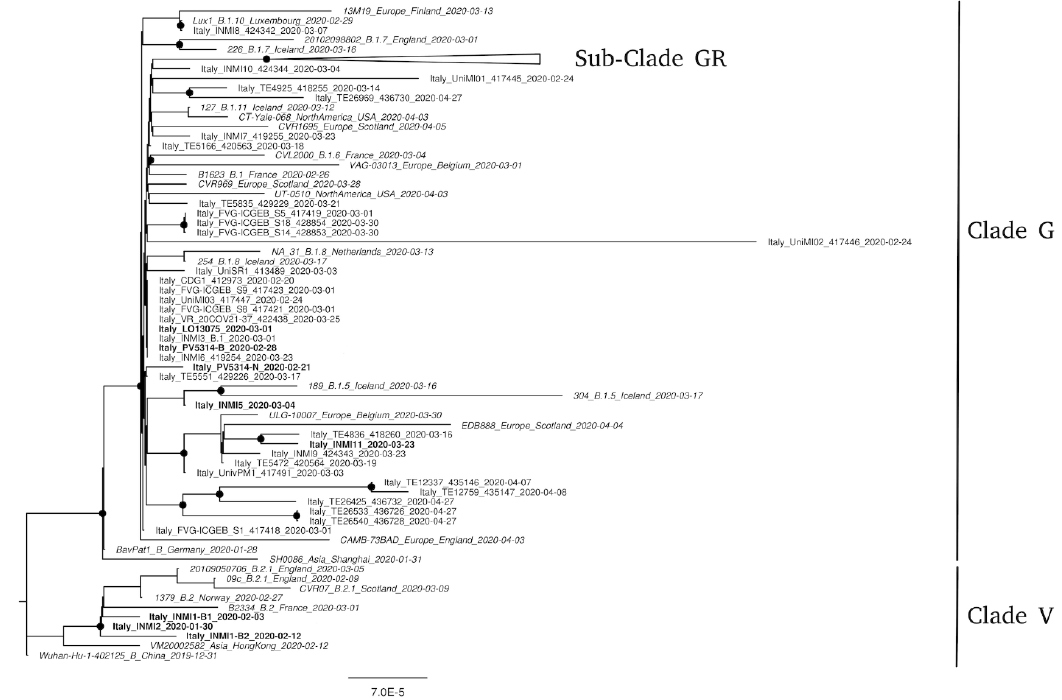
Figure 1. Phylogenetic analysis of SARS-CoV-2 strains circulating in Italy. Available genomes were retrieved from GISAID for 8 May 8, 2020, and all sequences from Italy were selected (see Methods). are included in the tree. Nodes with a bootstrap value of at least 70% are marked with a black dot. Scale bar represents the number of substitutions per site. All not Italians strains are reported in italics;